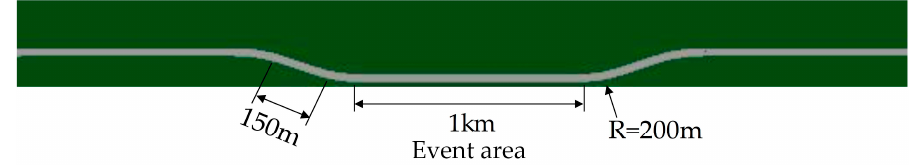
Figure 2. Segment for lane-changing event in DS environment.